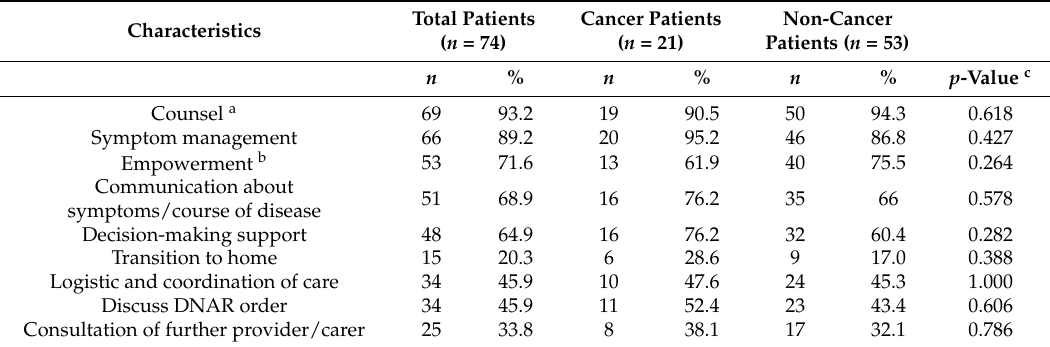
Table 3. Care goals.